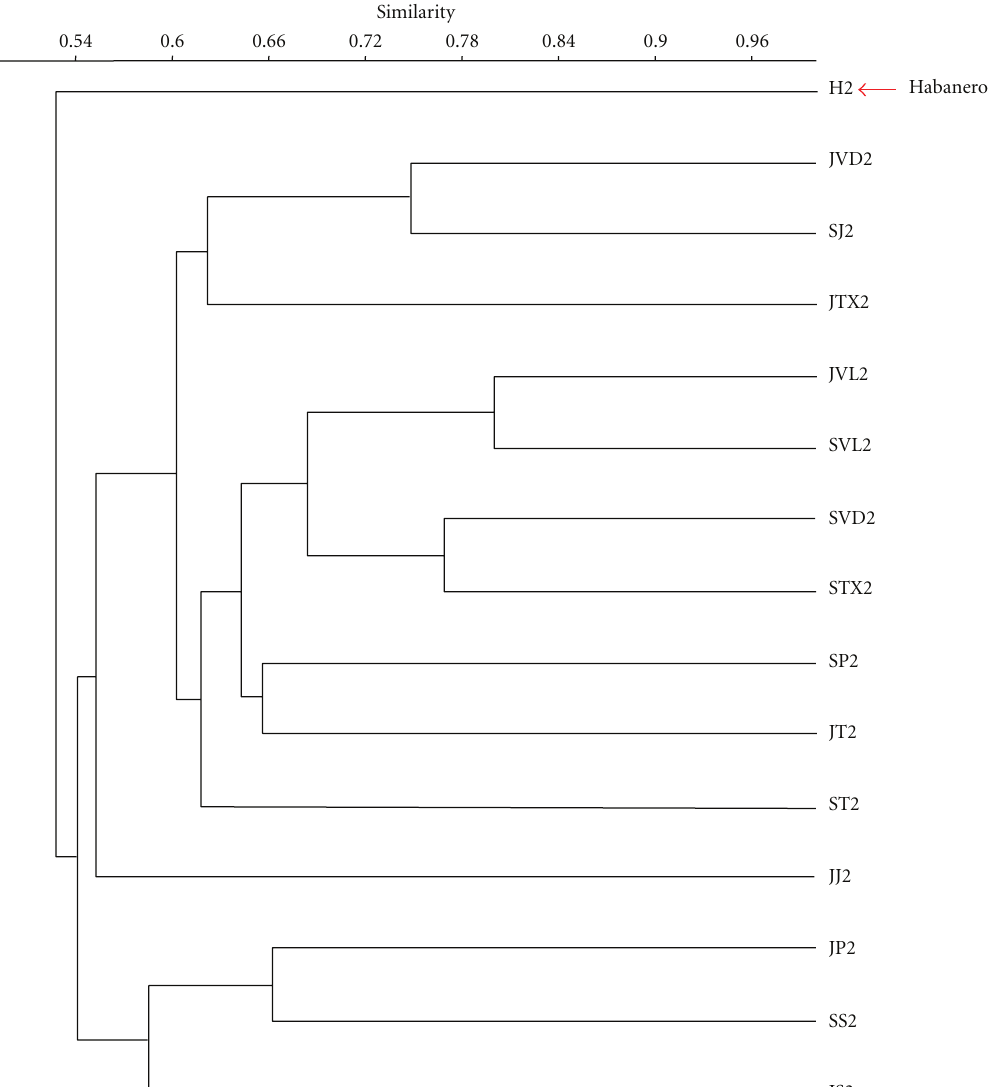
Figure 5: Dendrogram of Jalape˜no, Serrano, and Habanero chilli peppers, considering the presence/absence of polymorphic fragments as detected with the method RAPD by using the oligonucleotide OPE-18 and the chromatographic profile of carotenoids in mature